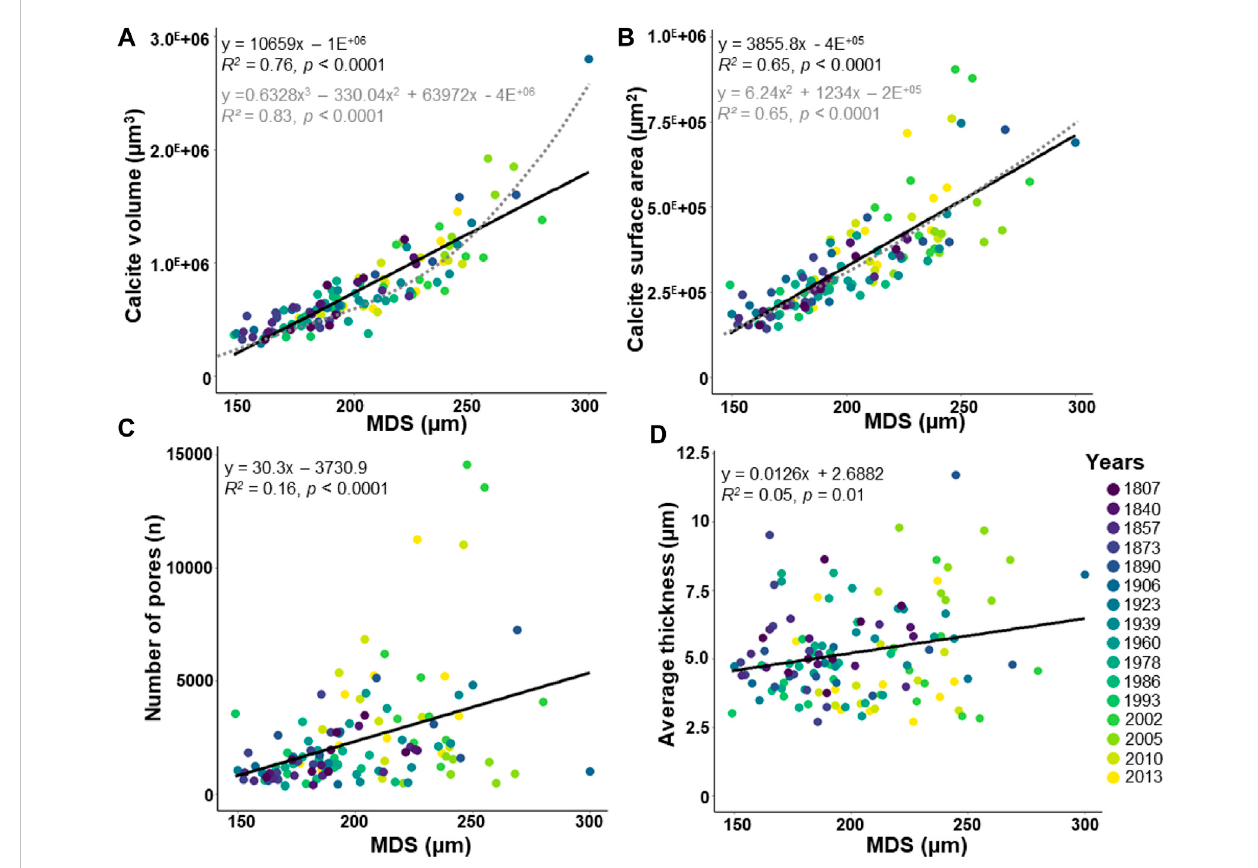
FIGURE 4 Morphologicalparametersaboutthemaximaldiameterofthespecimen(MDS).Thedatasetincludes124specimensof Elphidiumclavatum fromthe BalticSeaentranceoverthelast200 years (A) Calcitevolume(µm 3 ). (B) Calcitesurfacearea(µm 2 ). (C) Numberofpores. (D) Averagethickness(µm).Linear correlation (black line). Polynomial function (grey dotted